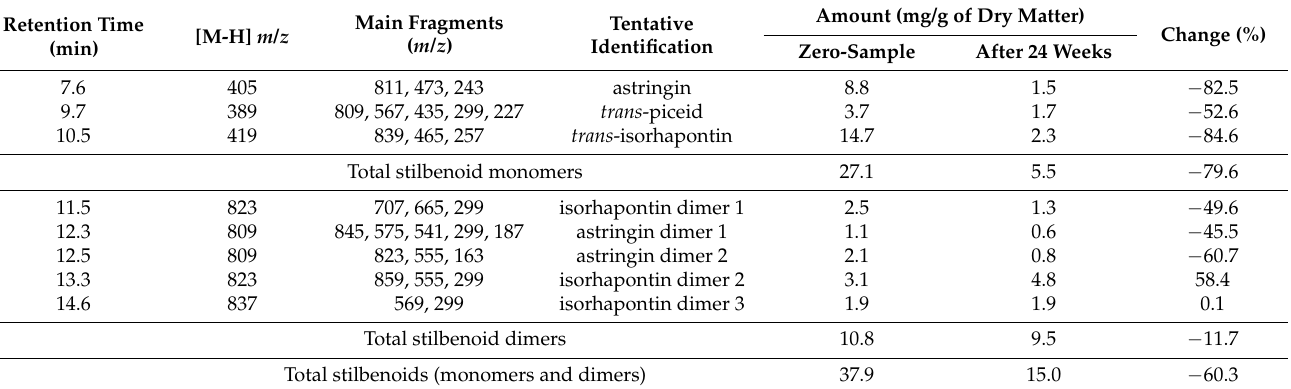
Table 5. The qualitative and quantitative results of the high-performance liquid chromatography (HPLC) analysis of bark hot-water